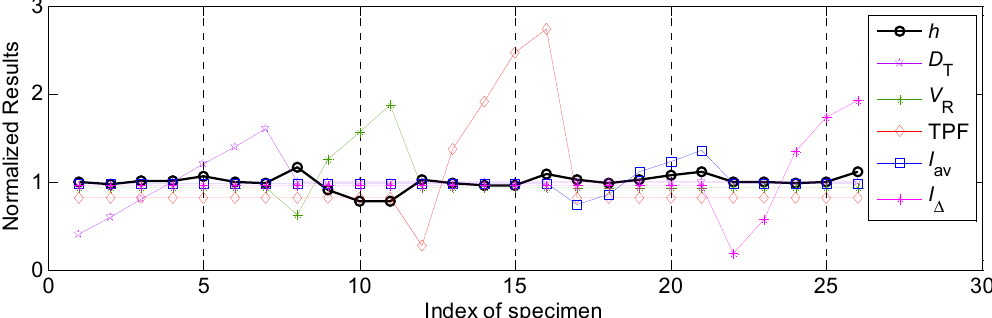
Figure 6. The normalized results of various process parameters and bead height.